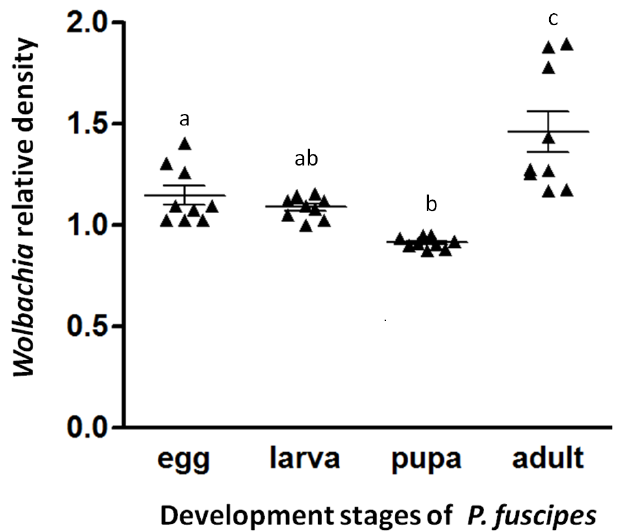
Figure 2. Relative Wolbachia density was measured across different developmental stages. Nine biological replicates were tested for each development stage. This would include both the individuals used from larvae to adults, and the egg pools. Each data point represents the average of three technical replicates. The bars represent mean ± standard error (n = 9) and the different letters above the scatter dot plot indicate a significant difference between developmental stages ( p < 0.05). Insects 2020 , 11 , x FOR PEER REVIEW